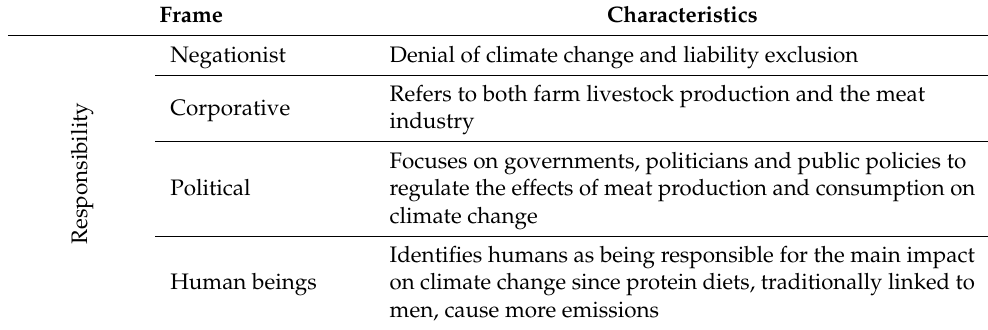
Table 2. Categories used for frame